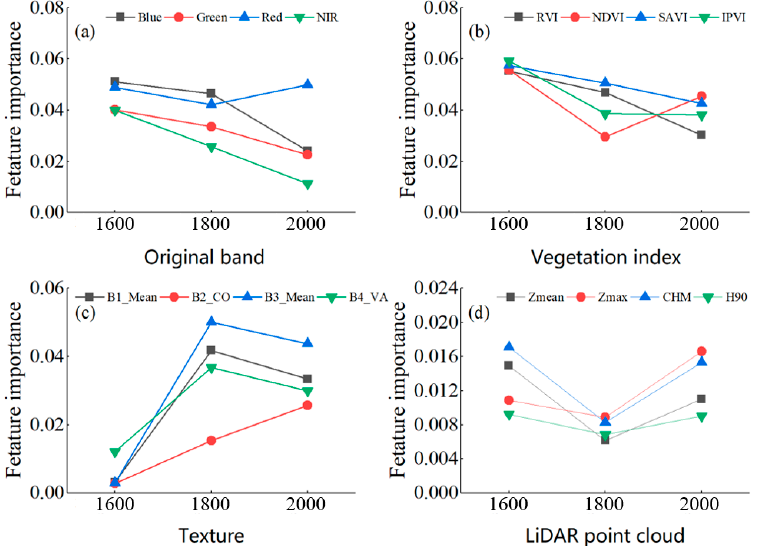
Figure 4. Comparison of importance values of optimal features at different altitudes: ( a ) Original band features; ( b ) Vegetation index features; ( c ) Texture features; ( d ) LiDAR point cloud features